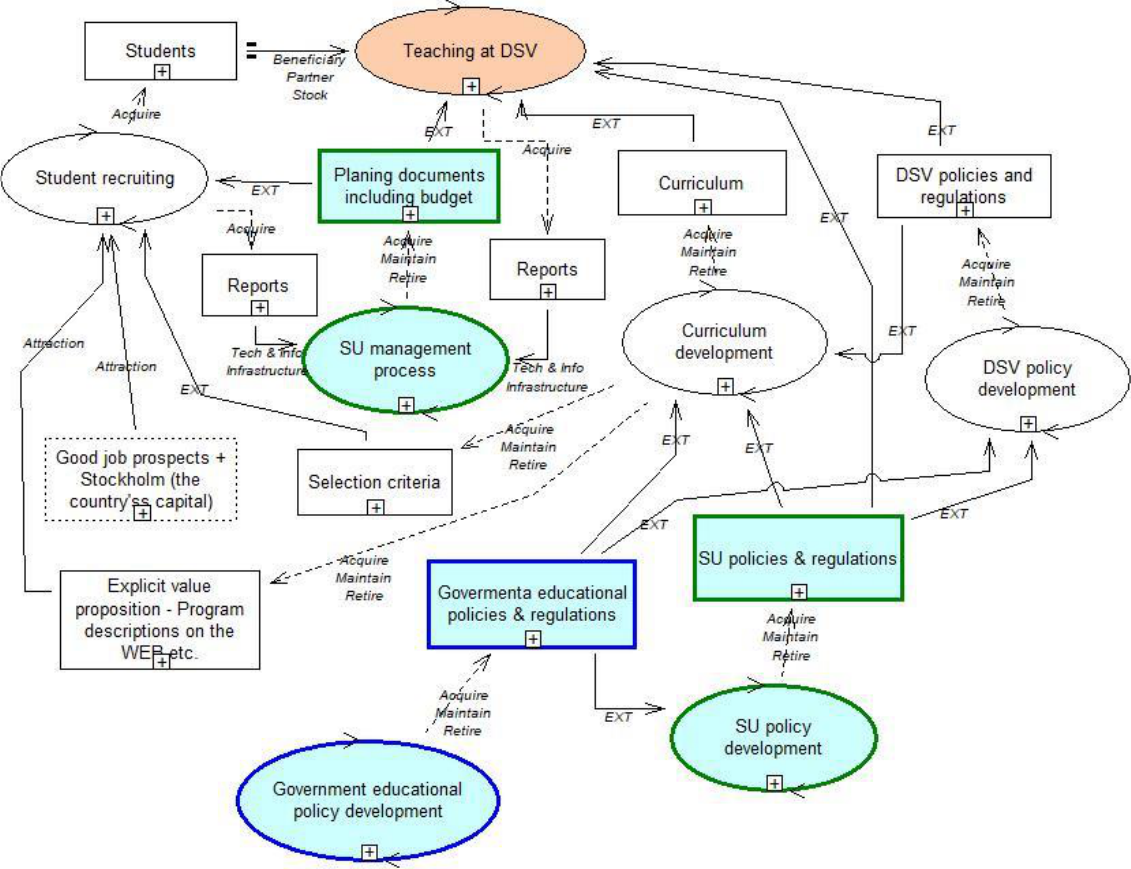
Figure 4. FEM of DSV extended with externally created